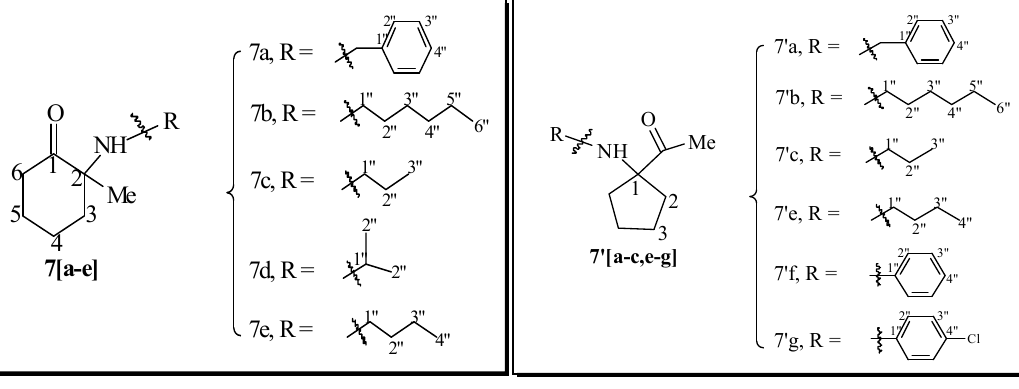
Table 6. Numbering system for NMR chemical shifts attribution for library 7a–g , 7  a–g . 7a, R